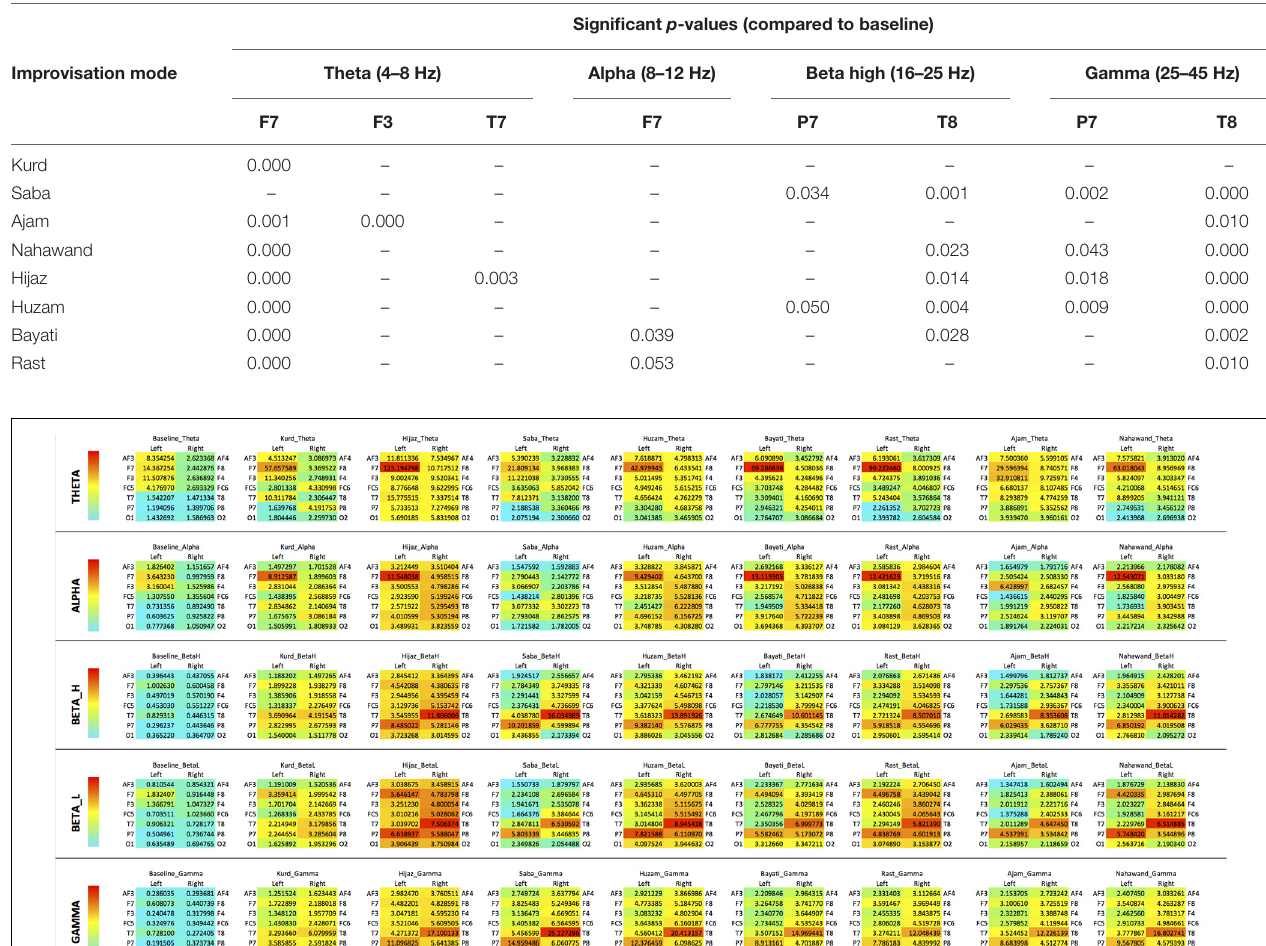
TABLE 2 | Proposed EEG signatures for improvisations at eight commonly used maqams .